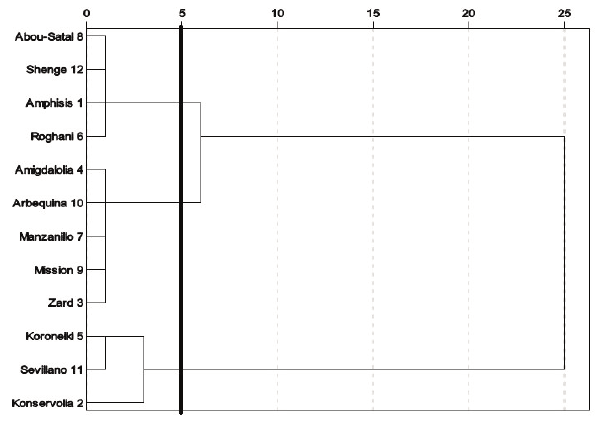
Fig. 3 - Dendrogram from cluster analysis based on Ward